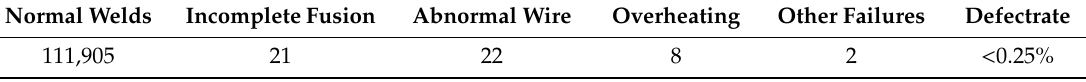
Table 2. Visual testing results.